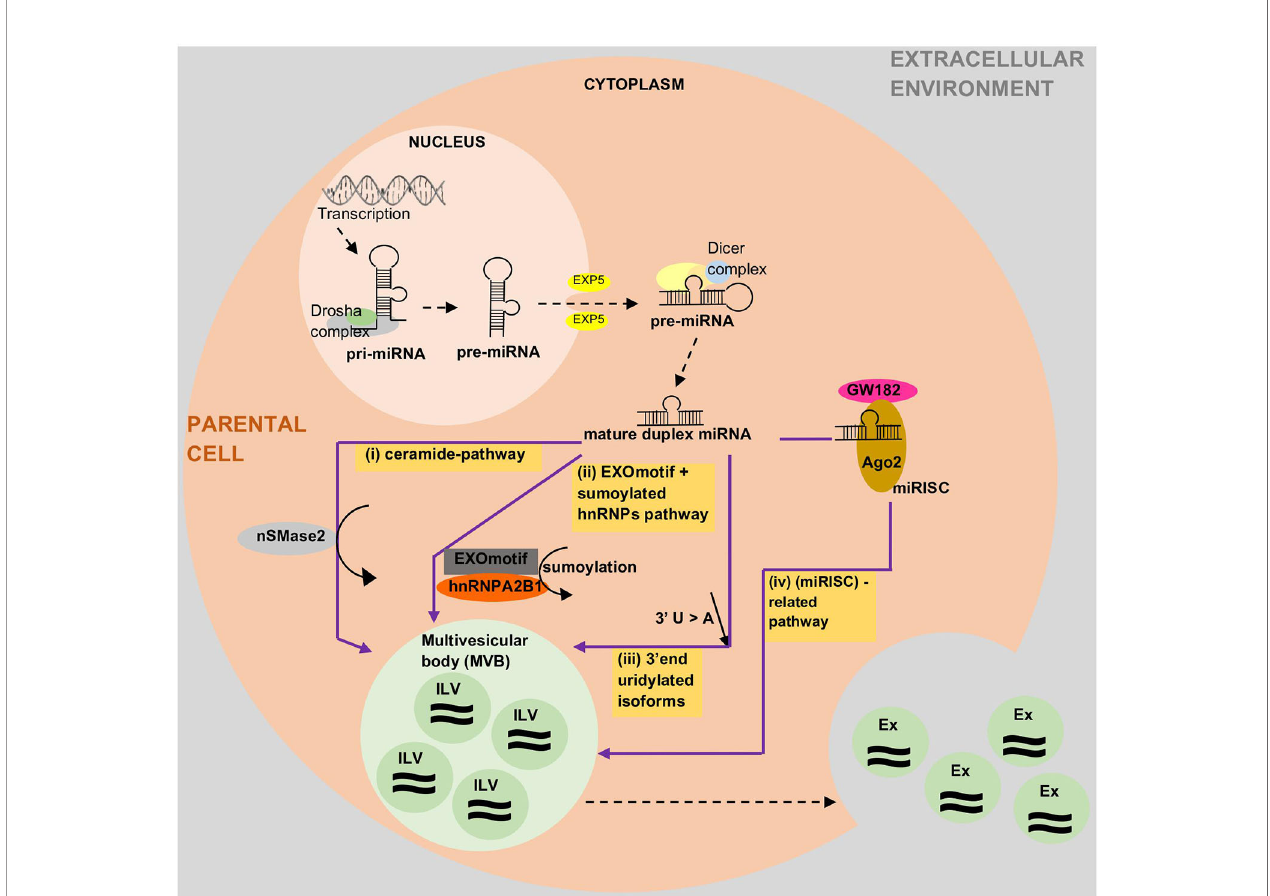
FIGURE 2 | Current state of knowledge on how miRNAs are loaded into exosomes and other extracellular vesicles (EVs). The proposed mechanisms are via (i) ceramide pathways, (ii) recognition of EXOmotifs and the sumoylated heterogenous nuclear ribonucleoproteins (hnRNPs)-dependent pathway, (iii) uridylated 3'end isoforms, or (iv) the miRNA-induced silencing complex (miRISC)-related pathway. Ago2, Argonaute-2; Ex, Exosome; EXOmotif, short sequence motifs in miRNAs; EXP5, exportin-5; hnRNPA2B1, heterogenous nuclear ribonucleoprotein A2B1; ILV, intraluminal vesicle; miRISC, miRNA induced silencing complex; nSMase2, neutral sphingomyelinase